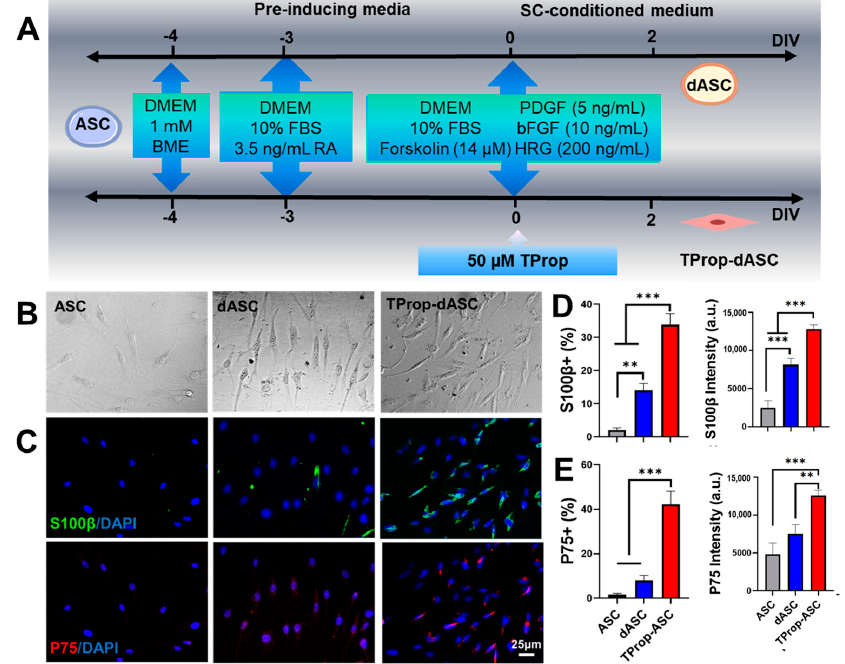
Figure 2. Characterization and comparison of Schwann-cell-like differentiation from ASCs with and without TProp after two days of treatment. ( A ) Schematic of the protocol used to differentiate ASCs into SC-like cells. ( B ) Optical microscopy images showed the flattened morphology in undifferentiated ASCs (ASC) and differentiated ASCs (dASC), whereas a spindle-shaped Schwann cell morphology was observed in the differentiated ASCs treated with 50 μ M TProp (TProp-dASC). ( C ) Immunofluorescence staining indicated higher levels of S100 (green) and P75 (red) protein expression in the TProp-dASCs. The scale bar is 25 μ m. Quantitative analysis based on percentage of positively stained cells and intensity of S100 ( D ) and P75 ( E ). Data represented mean ± SEM ( n = 3); ** p < 0.01, and *** p < 0.001, one-way ANOVA with Tukey’s post-test. With the extension of the induction period to 2 weeks, the rate of S100 β -positive cells percentage and their protein expression increased (Figure 3A), 8.029 ± 1.752, 35.34 ± 4.301, and 67.84 ± 1.376%; 6531 ± 1161, 14,378 ± 1175, and 22,013 ± 1795 for ASC, dASC,